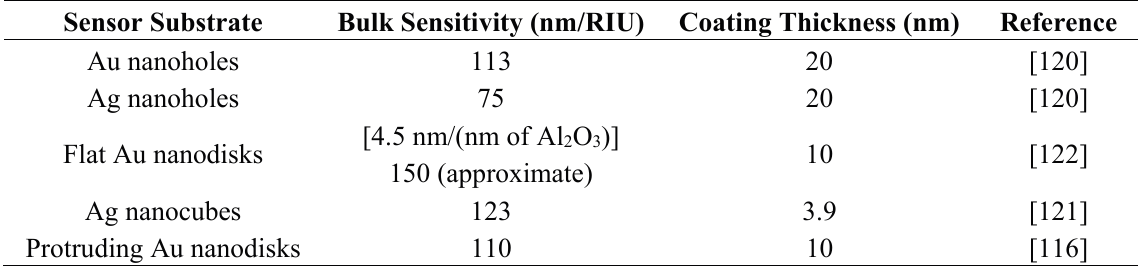
Table 1. Sensitivities of LSPR based bilayer constructs after being coated with a dielectric